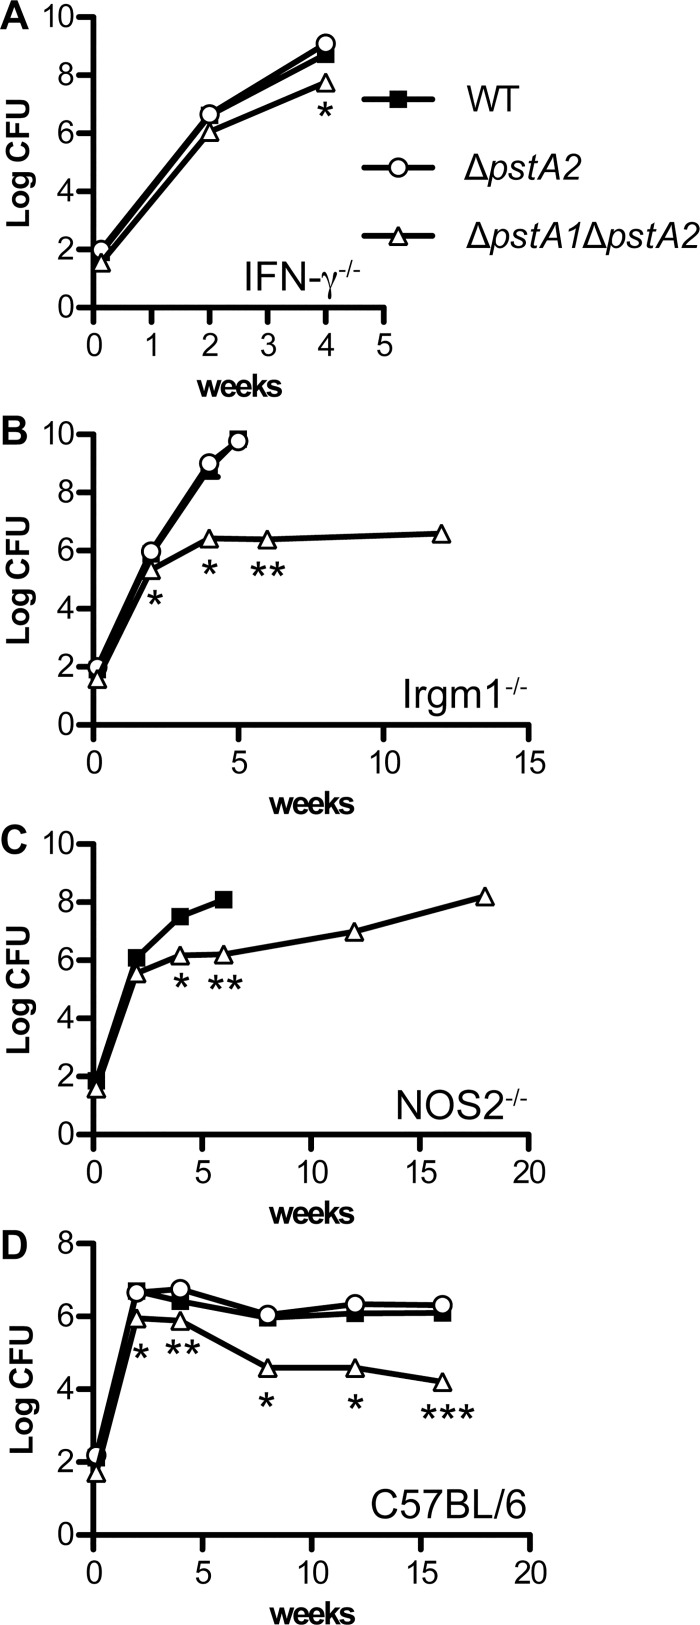
Growth kinetics of M. tuberculosis ΔpstA2 and ΔpstA1ΔpstA2 mutants in aerosol-infected mice.Mice were aerosol-infected with ~100 CFU of M. tuberculosis WT (squares), ΔpstA2 (circles), or ΔpstA1ΔpstA2 (triangles). Groups of mice (n = 4) were sacrificed at the indicated time points. Bacterial CFU were enumerated by plating serially diluted lung homogenates on 7H10 agar and incubating 3–4 weeks at 37°C. All mouse strains were on the C57BL/6 background. Symbols represent means; error bars indicate standard error of the mean. Asterisks indicate statistically significant differences between WT and ΔpstA1ΔpstA2: *P < 0.05, **P < 0.005, ***P < 0.0005. No significant differences in pulmonary CFU were observed between the WT and ΔpstA2 strains. (A) IFN-γ-/-, (B) Irgm1-/-, (C) NOS2-/-, (D) C57BL/6.